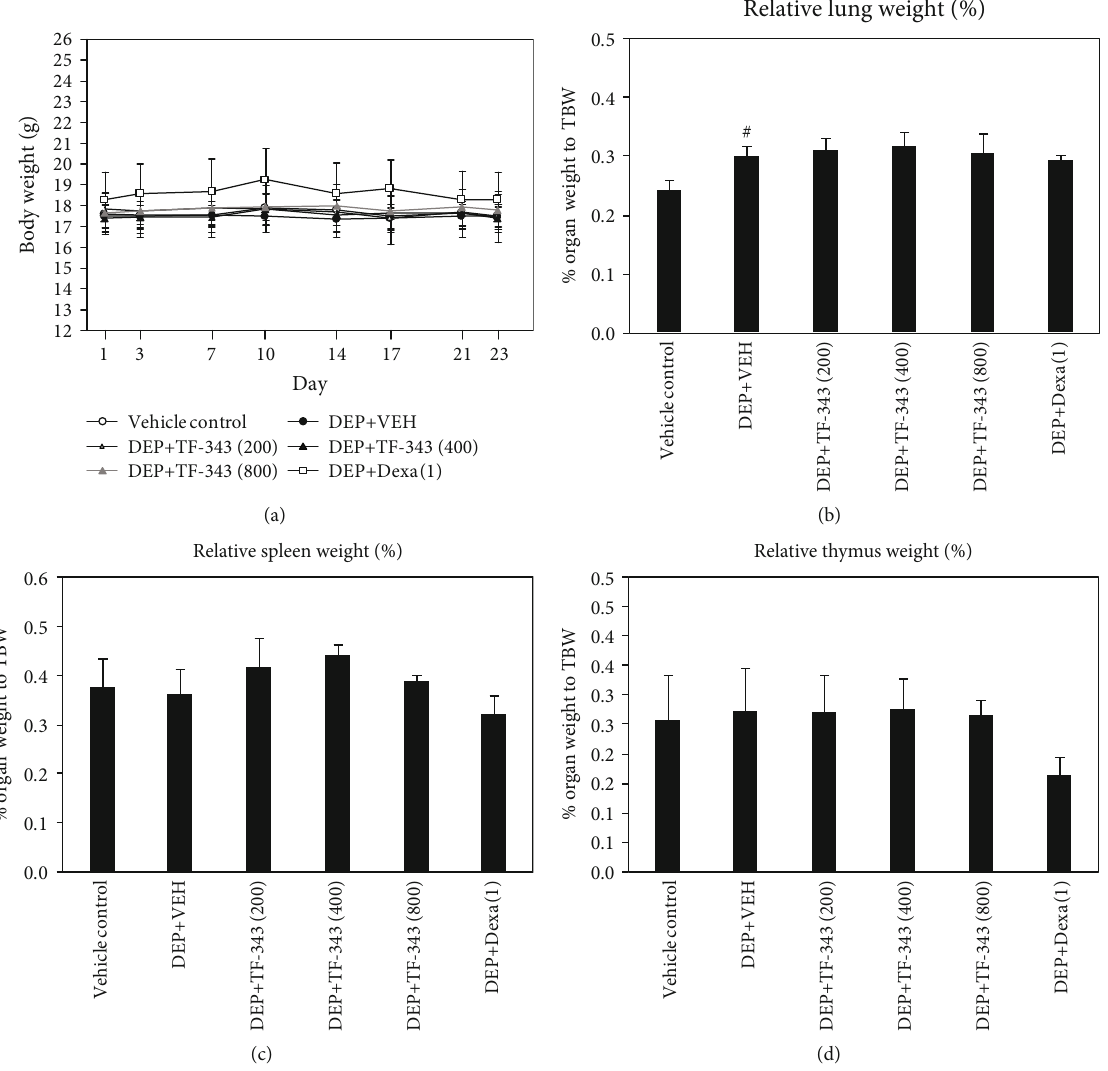
Figure 2: Changes in (a) body weight and (b-d) relative organ weight in DEP- and vehicle-treated mice. Lung (b), spleen (c), and thymus (d) weights were calculated with the following formula: relativeorgan weight = organ weight ð g Þ /final body weight ð g Þ × 100 % . Data represent mean ± SD ( n = 5 per group). # P < 0 : 05 vs. vehicle